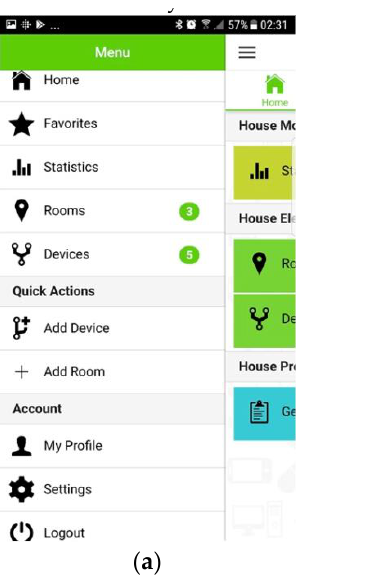
Figure 4. Interfaces of HEMS-IoT: (a) Menu, (b) Recommendations.